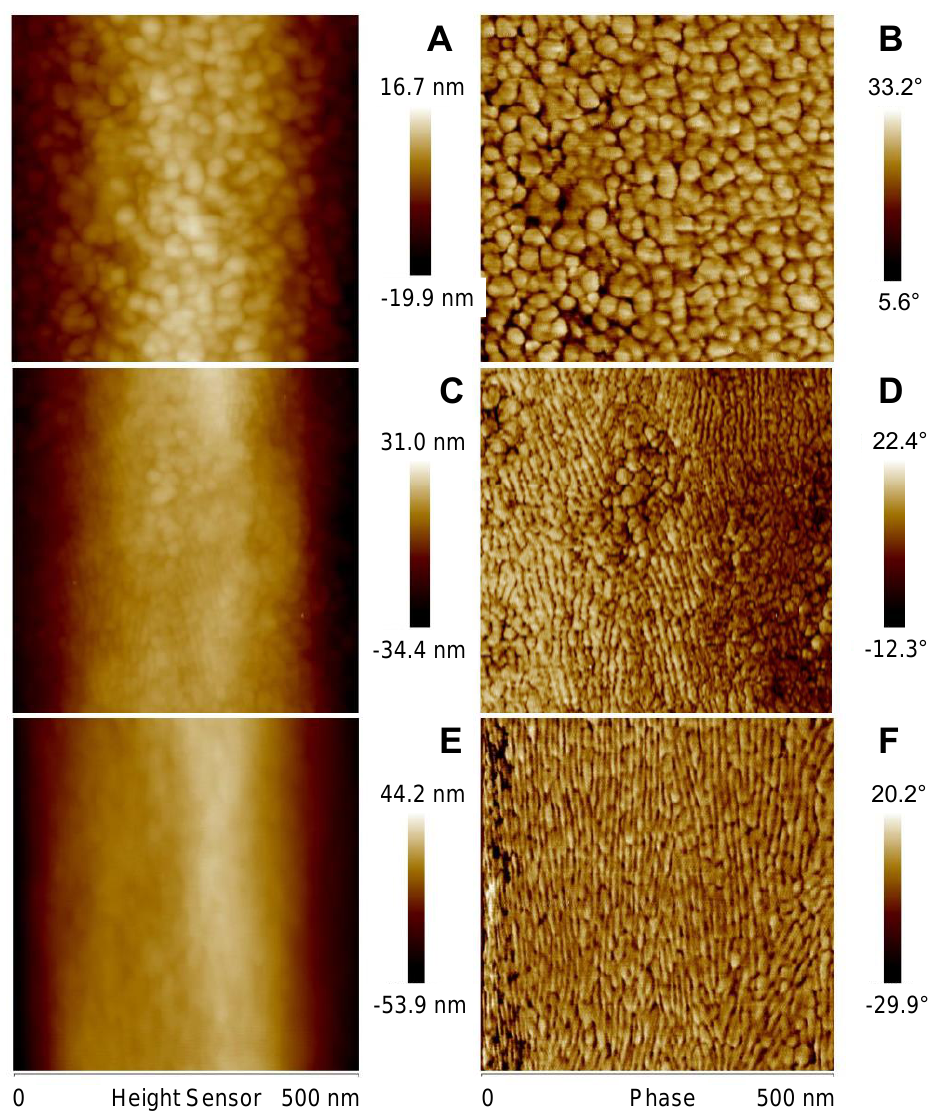
Figure 2. Enhanced resolution of nano–scale features of Arachnocampa tasmaniensis silk threads from phase imaging compared with height imaging. Simultaneous height ( A , C , E ) and phase images ( B , D , F ) were taken from three samples of glowworm silk threads.